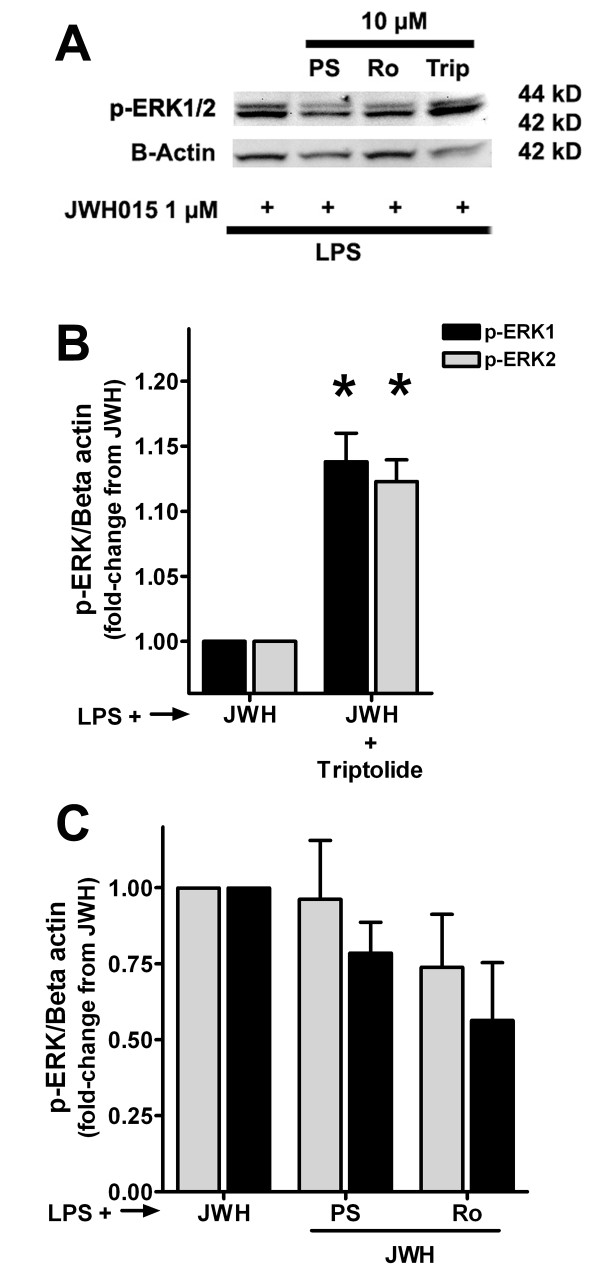
Effects of MKP-1 and/or MKP-3 inhibition on p-ERK1/2. (A) Representative western blots of p-ERK1/2 and beta-actin in primary microglia treated with LPS and JWH015 (15 min incubation, JWH). Cells were pre-incubated with or without 10 μM PSI2106 (PS), Ro-31-8220 (Ro) or triptolide (Trip) for 30 min. (B) Triptolide increased the expression of p-ERK1/2 in parallel with the inhibition of both MKP-1 and MKP-3. C. PSI2106 or Ro-31-8220 did not modify p-ERK1/2 expression. *p < 0.05 vs. LPS + JWH015.